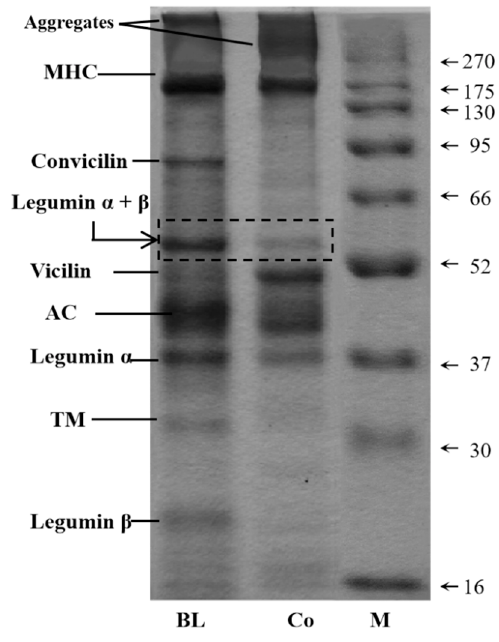
Figure 1. Non-reducing electrophoretograms of BL and Co. Table 2. Relative band optical density (%) of BL and Co (non-reducing